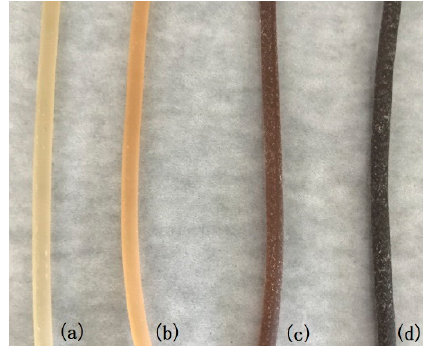
Figure 1. Appearance of HAS extrudates treated with different concentrations of NaOH. ( a ) Control; ( b ) 2% NaOH; ( c ) 6% NaOH; and ( d ) 10% NaOH.